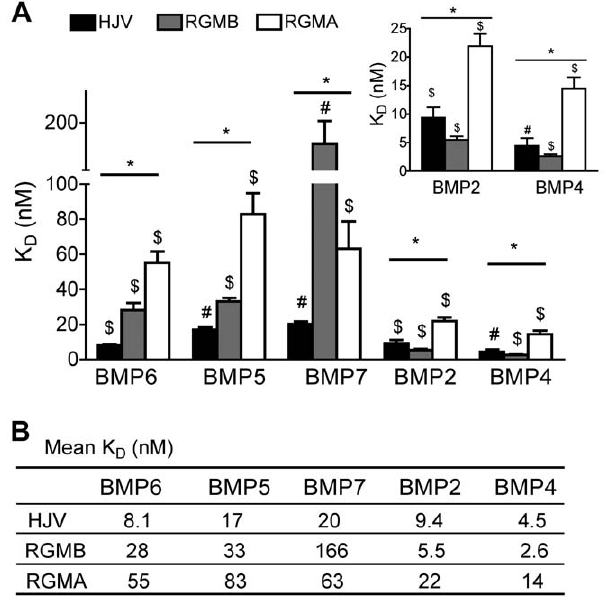
Figure 1. Binding affinity of RGM proteins for BMP ligands. ( A ) The binding affinity (K D =K off /K on ) of each RGM protein for each BMP ligand was measured by surface plasmon resonance and plotted as mean 6 SD (n=4–9 per group). The mean K D 6 SD of RGM proteins for BMP2 and BMP4 is also shown as an inset to better demonstrate their lower K D values. The mean K D is reported numerically in ( B ). ( A ) Black bar: HJV; gray bar: RGMB; white bar: RGMA. Statistical significance among 3 RGM proteins for binding to each BMP ligand was determined by one-way analysis of variance (ANOVA) with the Dunnett’s post-hoc test for pair-wise multiple comparisons (* all comparisons are significant ( P , 0.05)). For comparisons among 5 BMP ligands for binding to each RGM protein, one-way ANOVA with the Bonferroni’s post-hoc test was used ( # all comparisons are significant ( P , 0.05); $ not all comparisons are significant: for HJV, all pair-wise comparisons between BMP ligands are significant except for BMP2 vs BMP6; for RGMB, all pair-wise comparisons between BMP ligands are significant except for BMP2 vs BMP4 and BMP5 vs BMP6; for RGMA, all pair-wise comparisons between BMP ligands are significant except for BMP2 vs BMP4, BMP5 vs BMP7 and BMP6 vs BMP7.